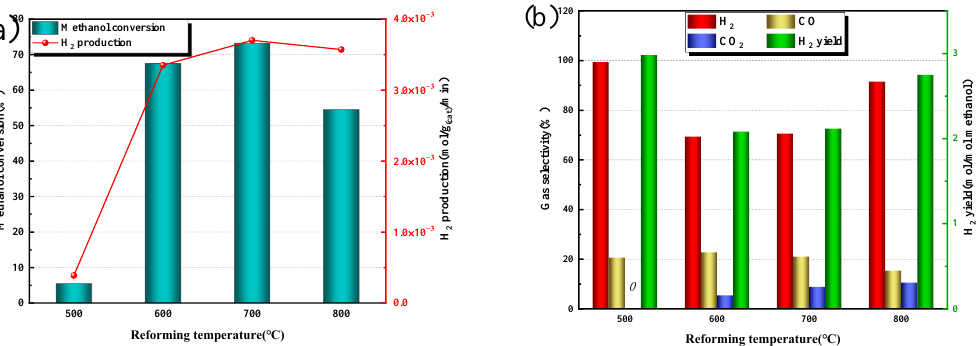
Figure 5. The MSR performance of the La 0.6 Sr 0.4 CeO 3- δ at different reforming temperatures: ( a ) methanol conversion (left Y) and hydrogen production of 1 g catalyst (right Y); ( b ) gas selectivity (left Y) and hydrogen yield (right Y).